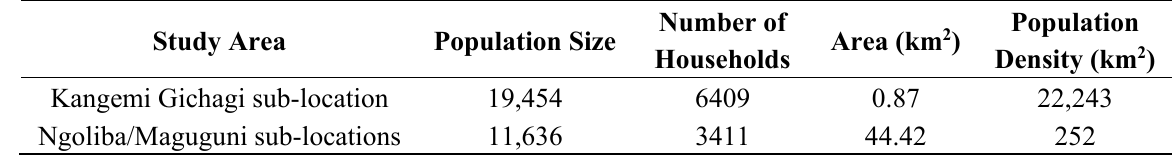
Table 1. Description of study areas according to the 2009 Kenya National Demographic Census